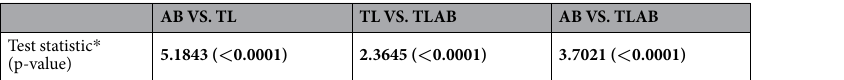
AB VS. TL TL VS. TLAB AB VS. TLAB Test statistic * (p-value) Table 2. The Hotelling’s T-squared test of Light-On VMR data used in Table 1. * These results are reproduced from 31 for comparison.